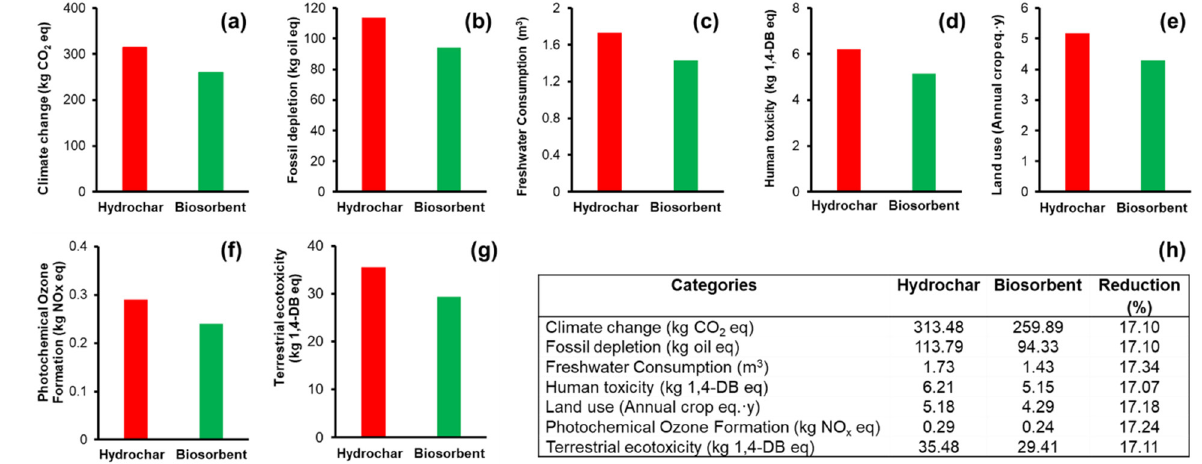
Figure 8. Life-cycle assessment of production of adsorbent materials from agave bagasse. Categories evaluated: ( a ) climate change, ( b ) fossil depletion, ( c ) freshwater consumption, ( d ) human toxicity, ( e ) land use, ( f ) photochemical ozone formation, ( g ) terrestrial ecotoxicity, and ( h ) comparative table between the environmental impacts of hydrochar vs. biosorbent.